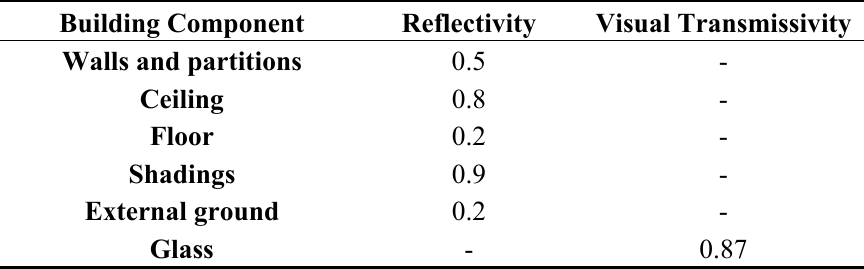
Table 2. Materials’ properties for daylight